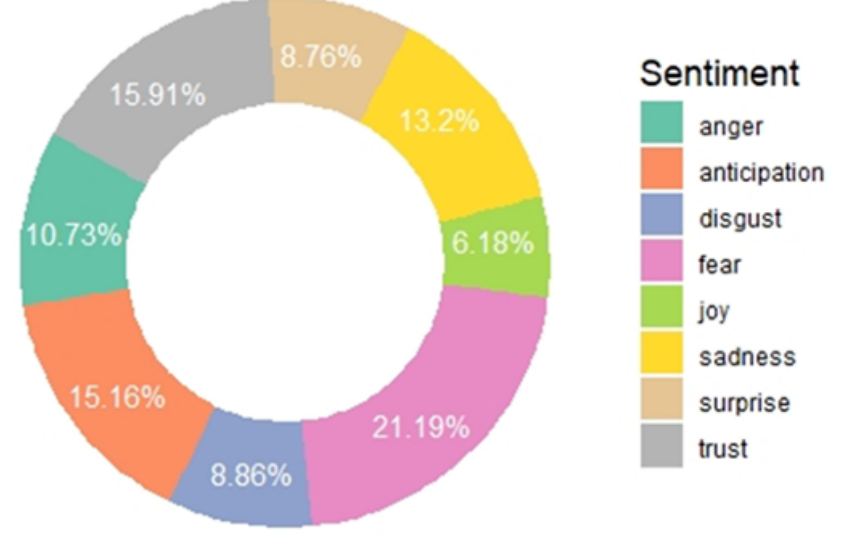
Figure 8. Sentiment wheel showing the emotional quotients of the studied tweets.